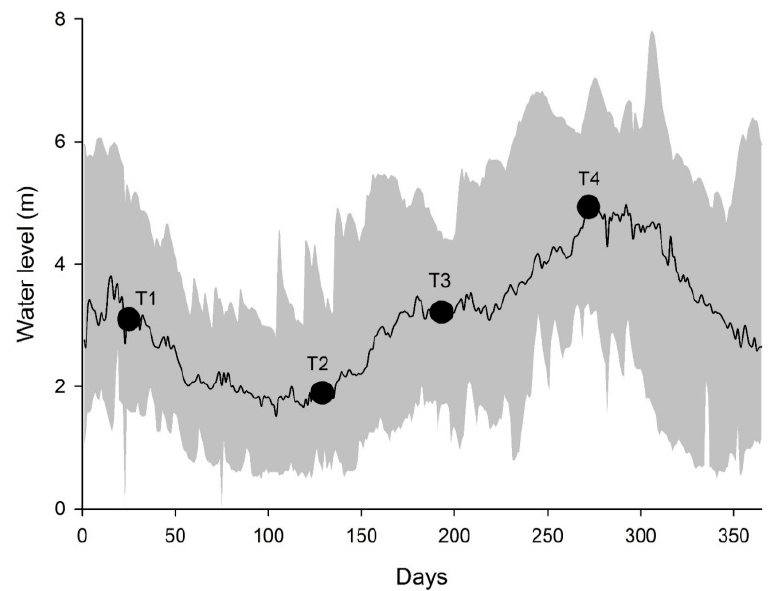
Figure 2. Daily water level variations in the Grijalva River. Water level data were taken from the hydrometric station of Las Gaviotas II, key 30,083 [47]. 4 sampling periods = black circle (T1 = transition to low level; T2 = low level; T3 = transition to high level; T4 = high level). Grey area = minimum and maximum water level. Black line = average water level (2005–2014).